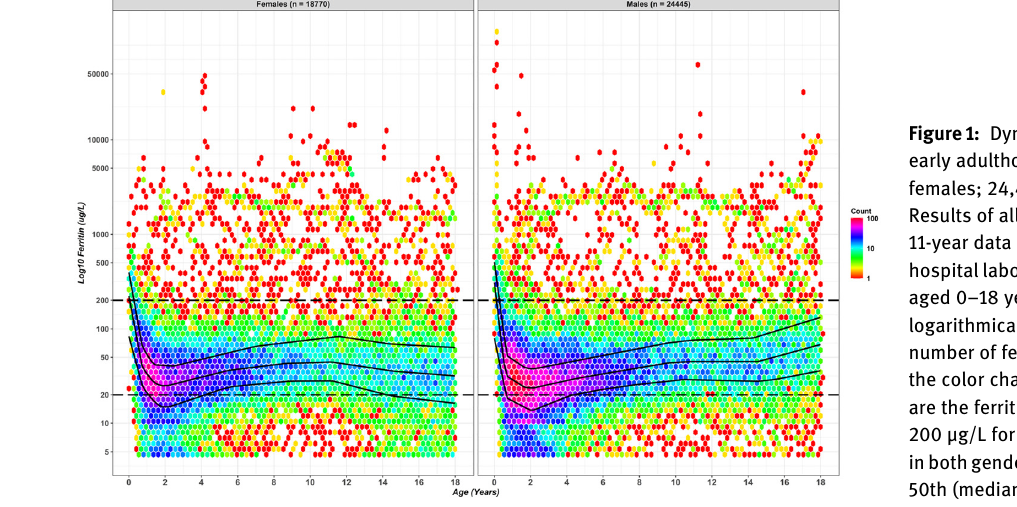
Figure1: Dynamicsofferritinfrombirthinto early adulthood for both genders (18,770 females; 24,445